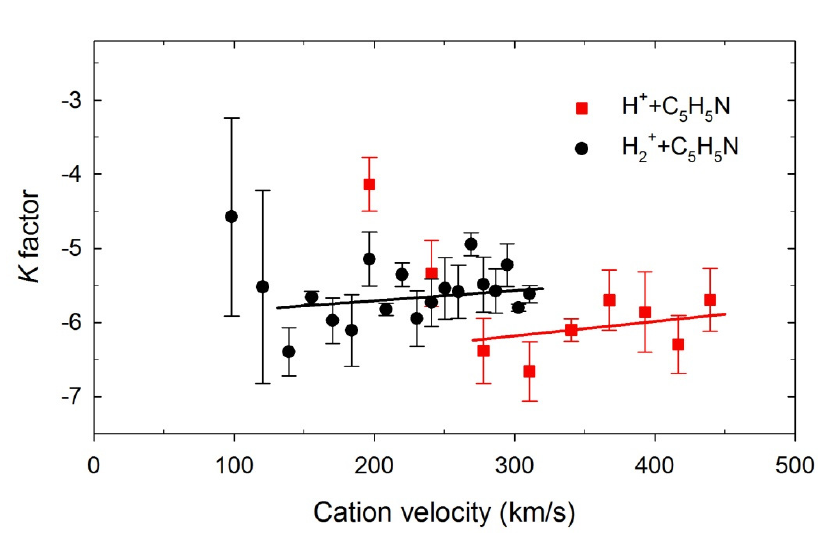
Figure 5. The K factors as a function of incident cation velocity. The solid lines represent overall trends at higher velocities. trends at higher